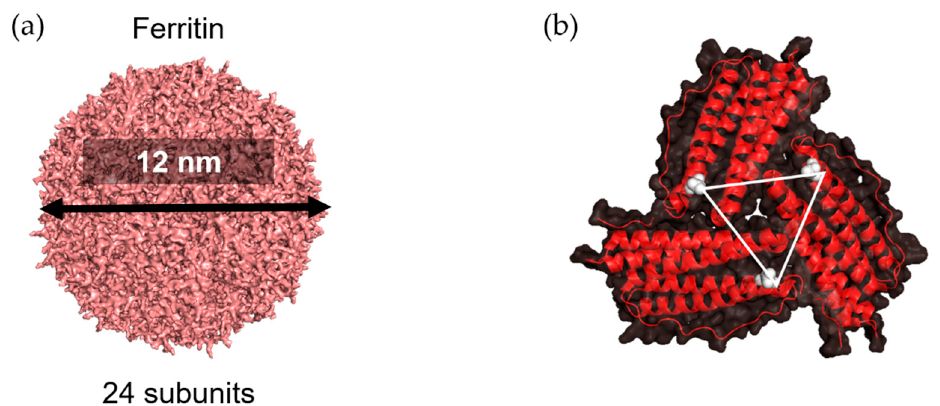
Figure 6. Three-fold axis structure in ferritin. ( a ) Structure of ferritin as 24-subunit assembly (PDB ID: 3BVE using PyMOL). ( b ) A three-fold axis formed by three subunits is shown; the Asp 5 residue in each chain is colored in white; the triangle represents distance among three Asp 5 residues.